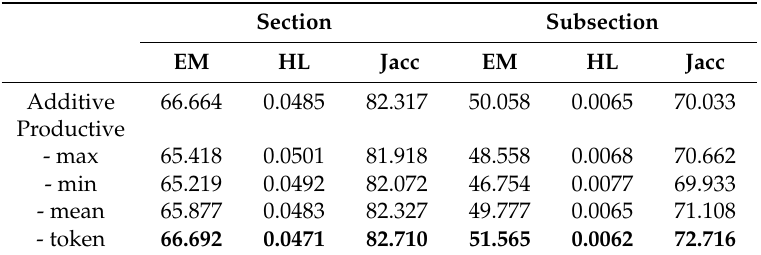
Table 3. Ablation study on D-Block variations.